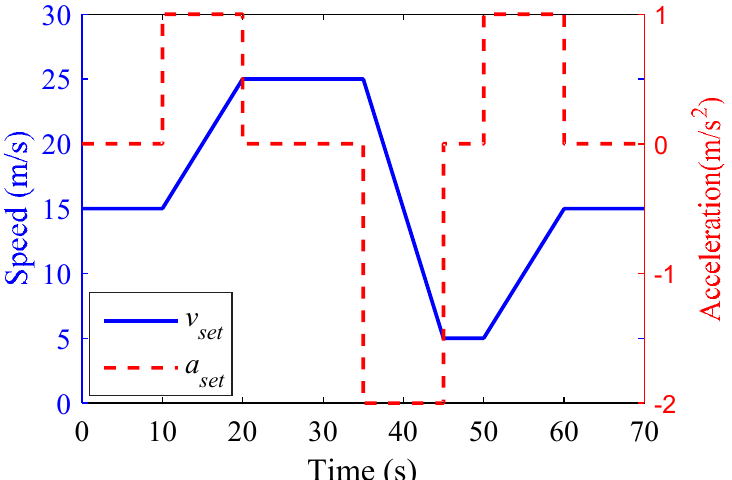
Figure 5. Profile of leading vehicle movement state.